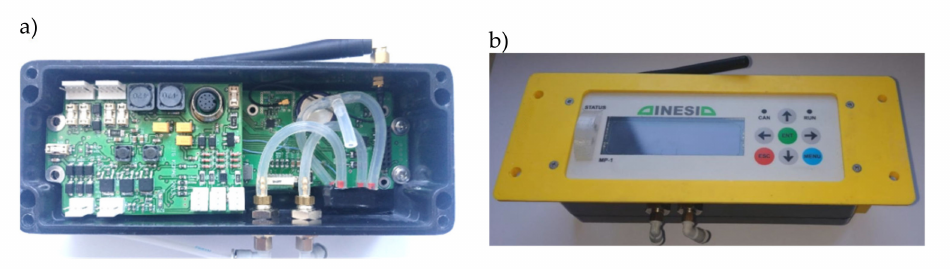
Figure 6. Measuring device prototype: ( a ) inside view, ( b ) front view.